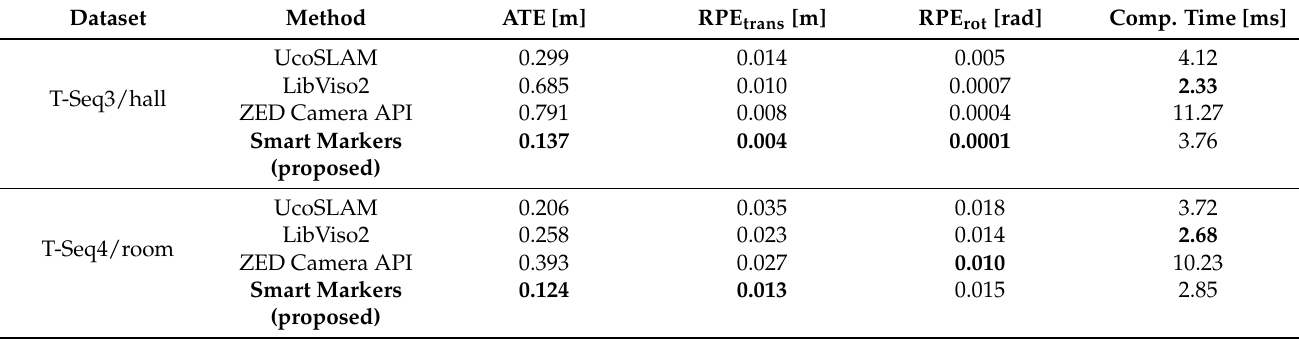
Table 4. Accuracy of the camera localization. ATE (RMSE) metric and RPE (RMSE) computed from translational and rotational pose parts, and processing times for datasets T-Seq3/hall and T-Seq4/room .